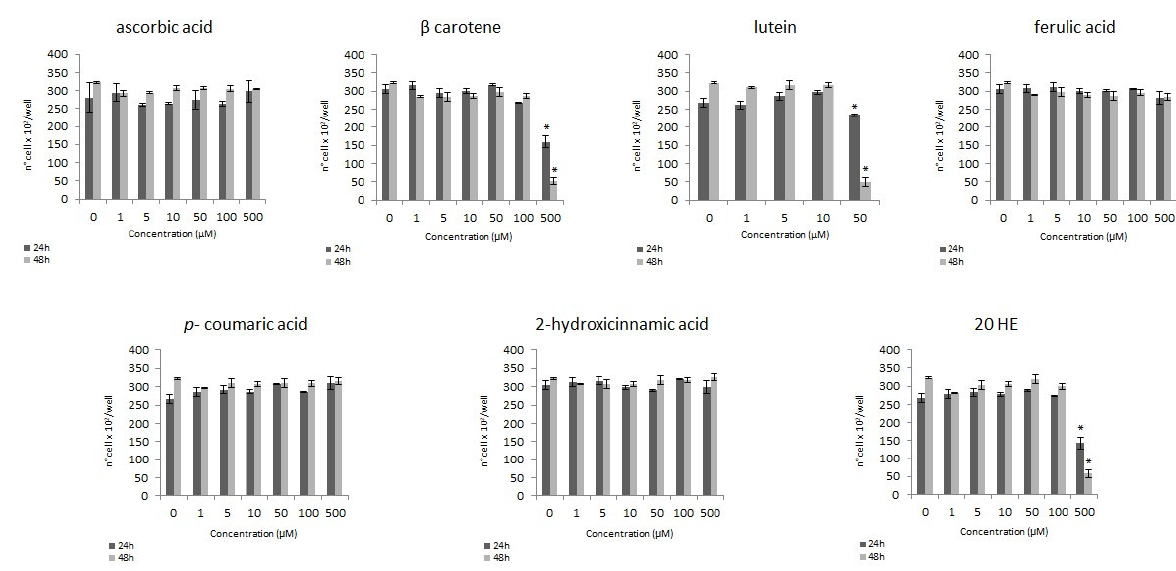
Figure 1. Modulation of the proliferation of HT29 cell line: number of cells/well on concentration after 24 and 48 h of treatment with increasing phytochemical concentration (* p < 0.05).